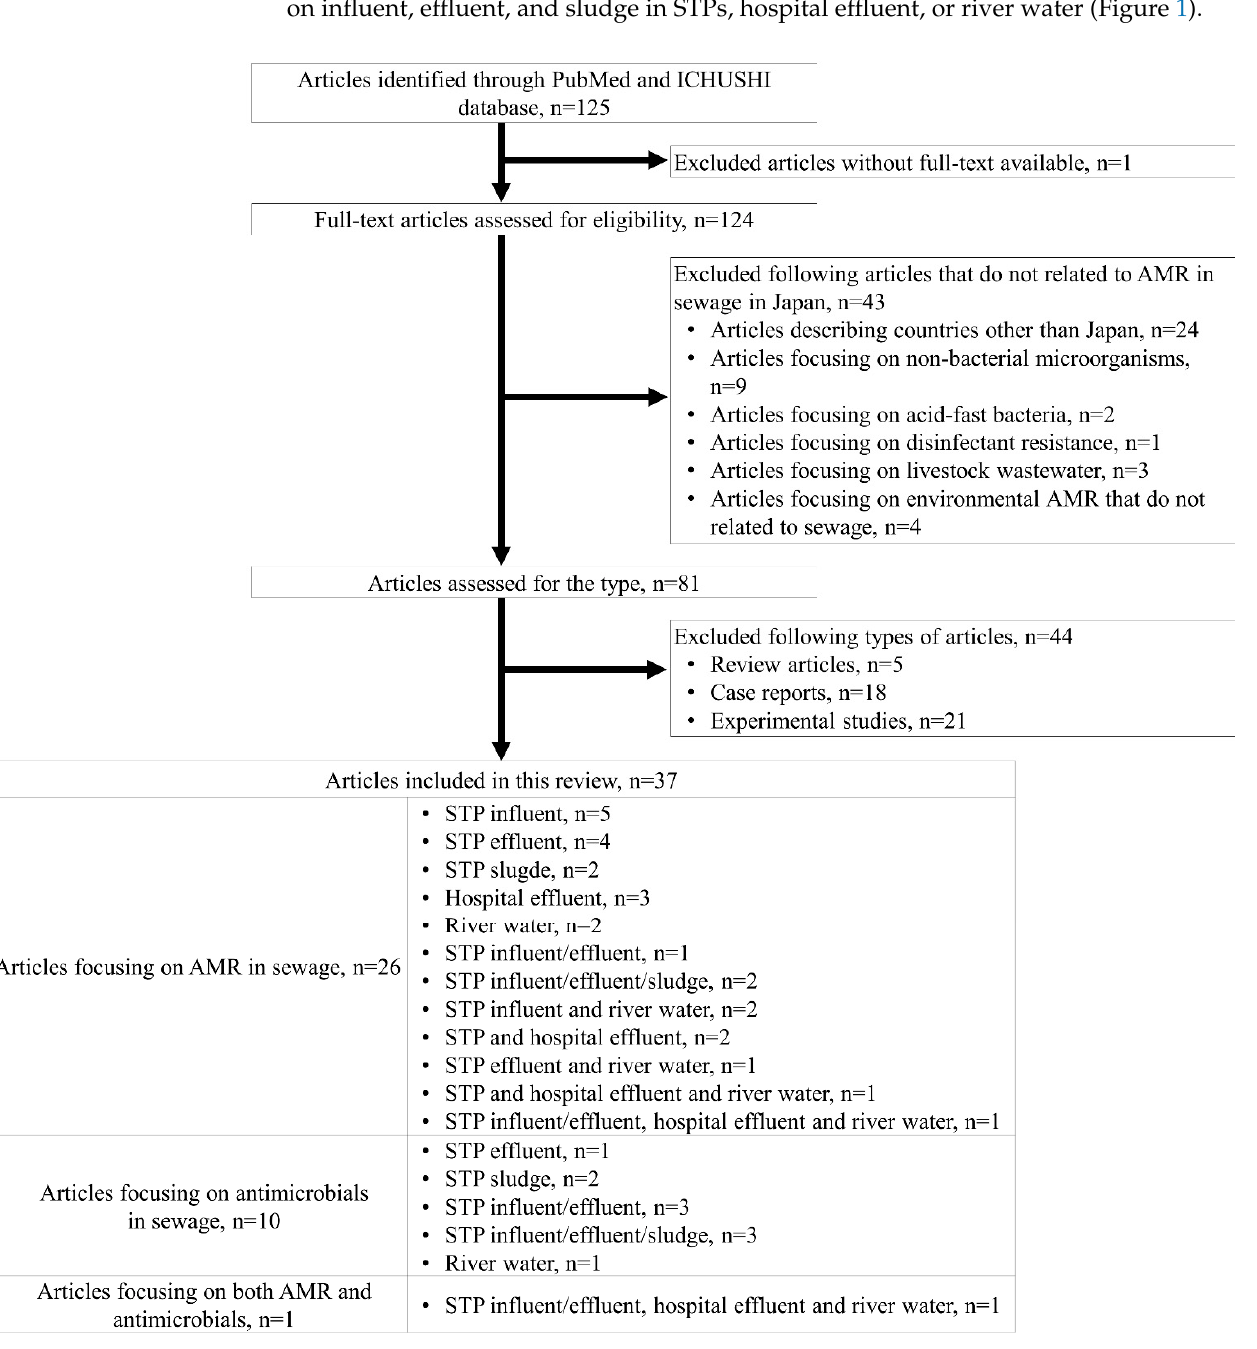
Figure 1. Flow chart of the review process and article screening results. Abbreviations: ICHUSHI, Igaku Chuo Zashi; AMR, antimicrobial resistance.